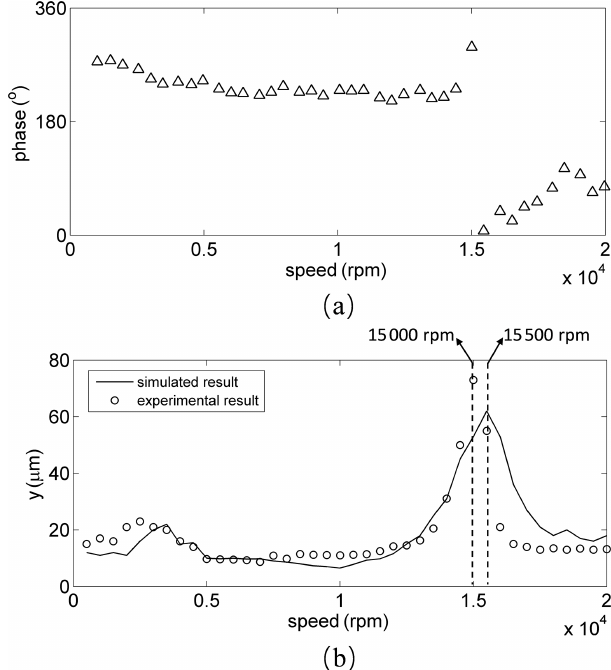
Figure 4. Experimental results: (a) Bode diagram of the gear-rotor system obtained experimentally. (b) Comparison of experimental and numerical